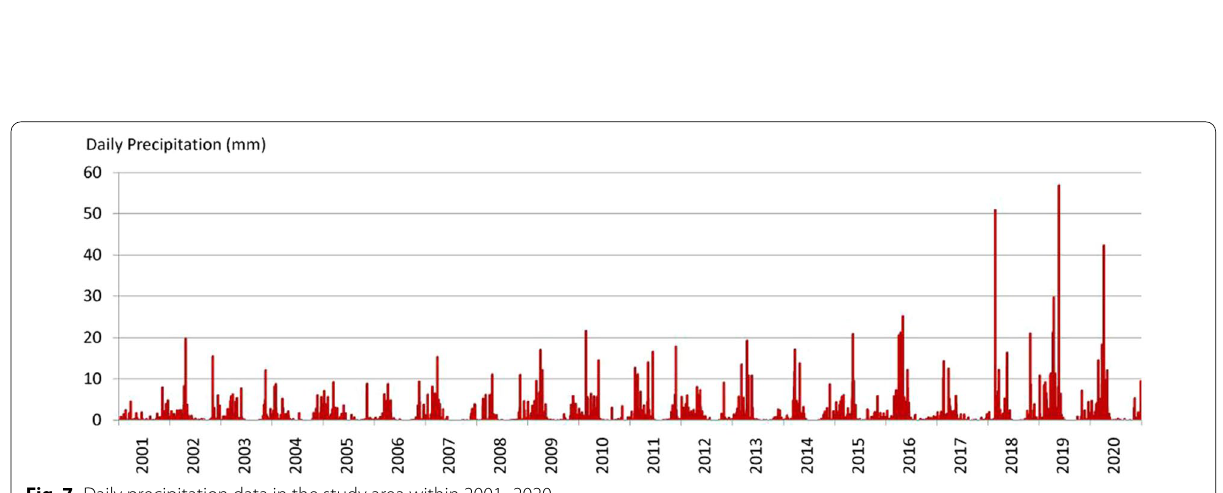
Fig. 7 Daily precipitation data in the study area within